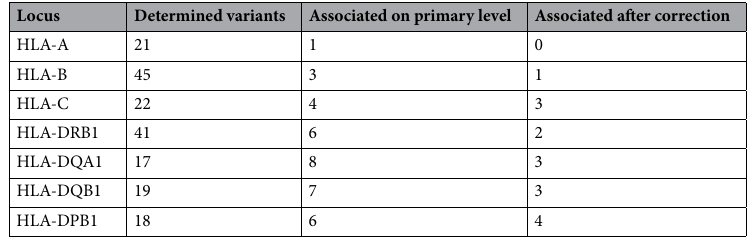
Table 1. Determined and associated alleles in seven HLA loci. Numbers of alleles that we were able to distinguish using NGS HLA genotyping and numbers of sarcoidosis associated alleles in seven HLA loci (primary level = before correction for multiple comparisons). HLA human leukocyte antigen.